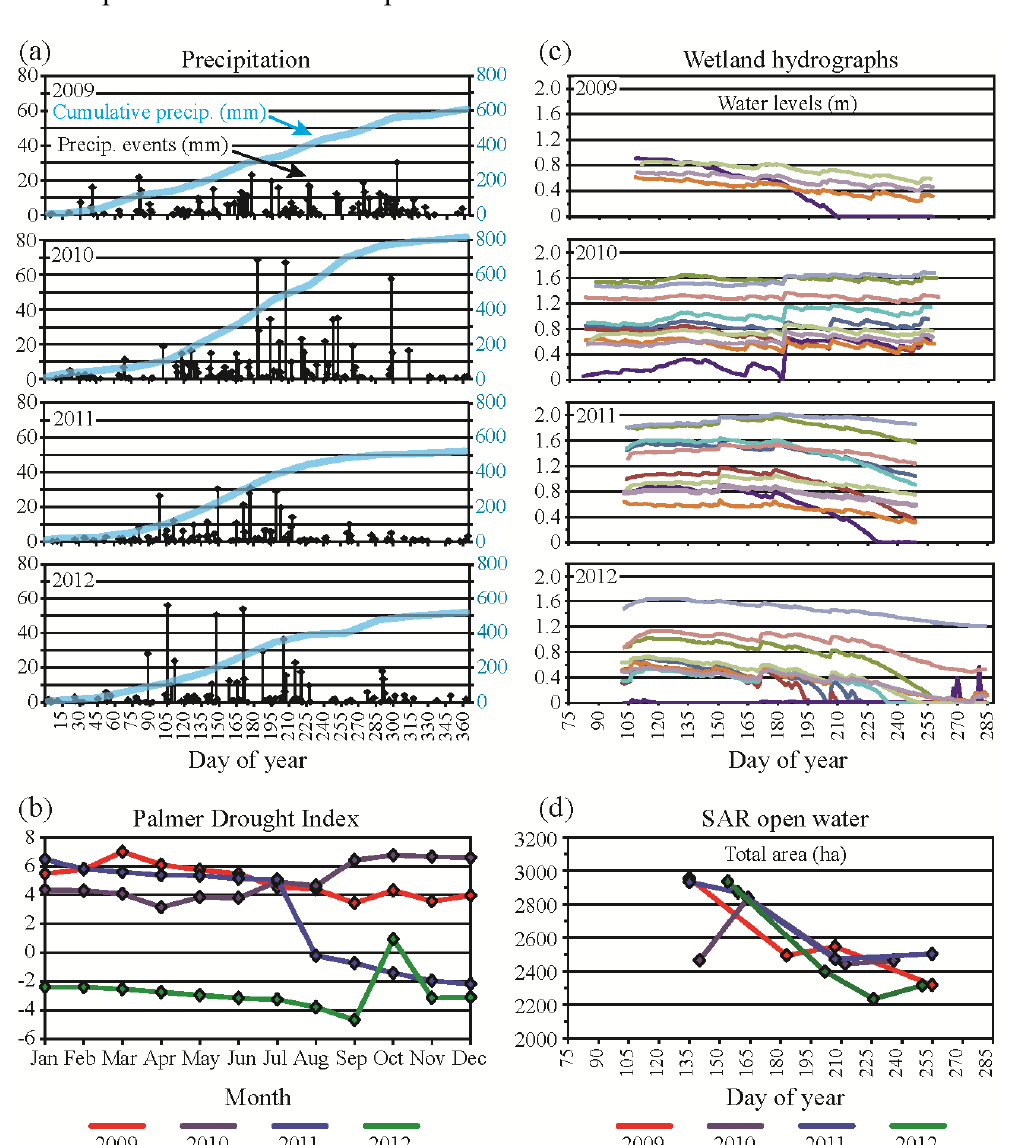
Figure 6. Ground-based information on moisture versus extent of open water mapped with SAR data complemented with Landsat near-infrared data. Graphs of precipitation input ( a ) show interannual differences in delivery of water, both in individual events and in cumulative totals. The interplay between air temperature, moisture availability, and photoperiod affected the demand for evapotranspiration and resulted in varying drought status over time ( b ). Hydrographs for wetlands monitored in situ ( c ) corresponded with the changing conditions recorded in the precipitation record and with the estimated drought status (note: each colored line represents a different monitored wetland, and the same color is used for the same wetland across years). Total amount of water mapped with SAR data ( d ) captured some, but not all, of the general patterns of changing conditions in moisture availability. Note regarding ( b ): negative values of the Palmer Drought Index denote dry spells and positive values indicate wet spells. Values 0 to − 0.5 = normal conditions; − 0.5 to − 1.0 = incipient drought; − 1.0 to − 2.0 = mild drought; − 2.0 to − 3.0 = moderate drought; − 3.0 to − 4.0 = severe drought; and greater than − 4.0 = extreme drought. Similar adjectives are used for positive values of wet